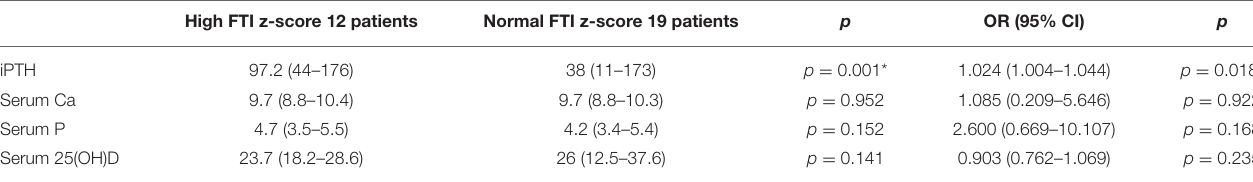
TABLE 3 | Mann-Whitney and univariate logistic regression analysis to identify association of mineral metabolism laboratory parameters with high fat tissue index (FTI) z-score (12 patients) in chronic kidney disease (CKD) stage 3 patients. High FTI z-score 12 patients